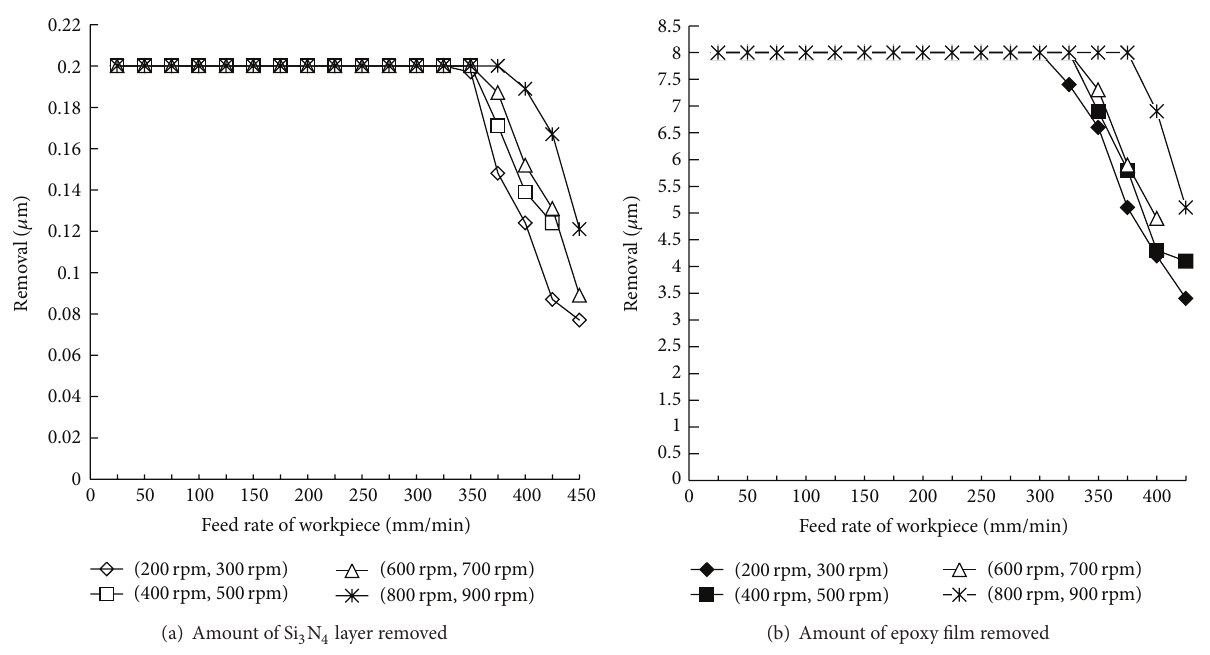
Figure 7: Amount of Si 3 N 4 layer and epoxy film removed at different feed rates of workpiece using different combinations of tool revolution speed (shift) and tool rotational speed (phosphoric acid 25% wt, NaNO 3 15%wt, PO4-3-P 5% wt, 60 ∘ C, 40L/min, continuous DC, 150A, 100kHZ/150W, and 4000